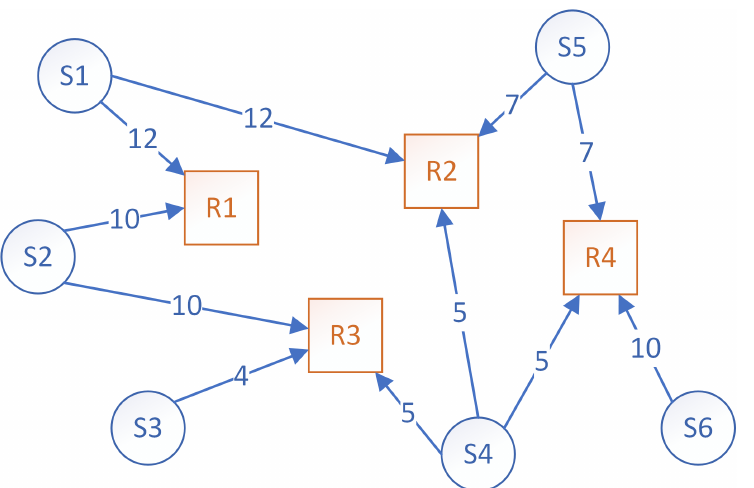
Figure 2. Example of the connections between six sensors ( S ) and four rules ( R ). Each sensor, represented by the round vertices, produces the amount of data specified on the graph edge, and those data have to be processed by the rules, represented by square